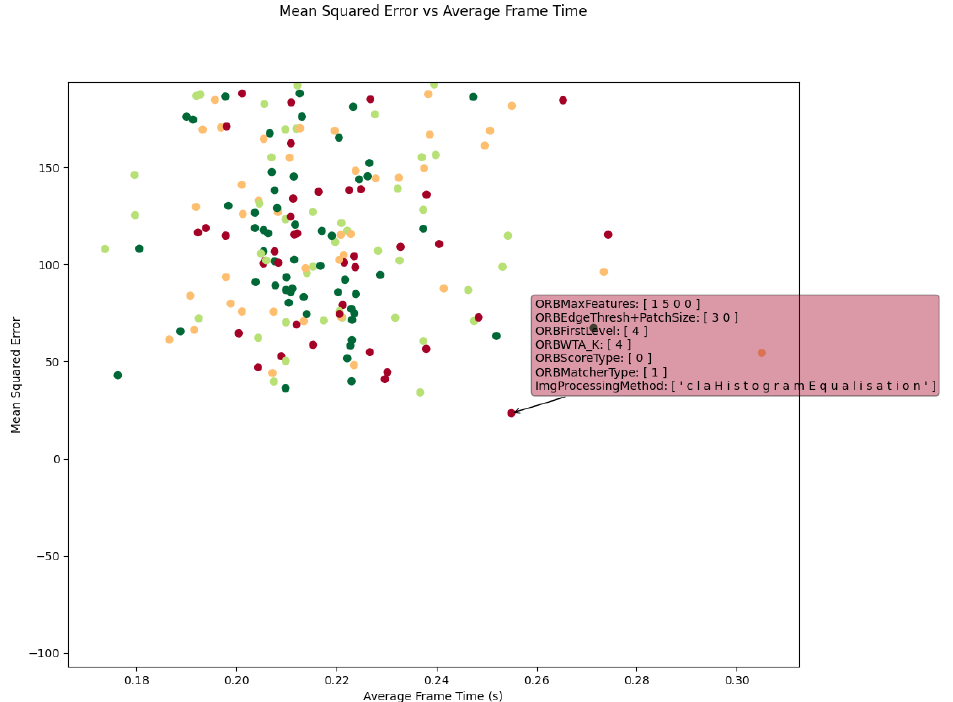
Figure 18. Results of Different Image-Processing Techniques and Feature-Matching Parameters on the Accuracy of VO Relative to the Structure-from-motion “ground truth”: the test with the smallest error is highlighted and the settings for that test